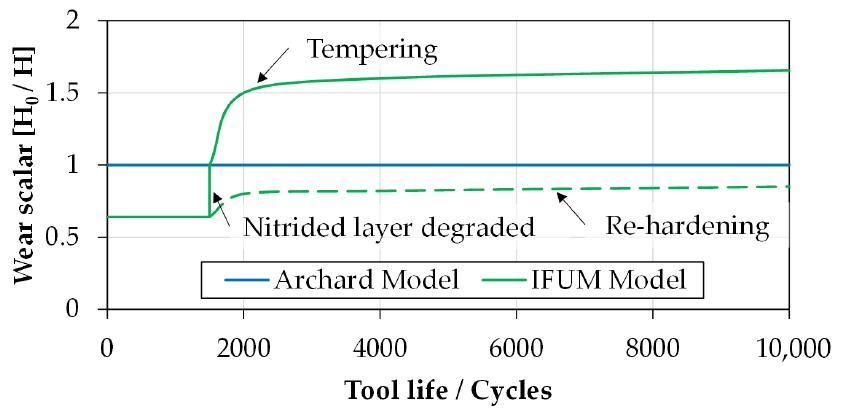
Figure 14. Wear scalar for calibrating the wear using the IFUM model compared to the Archard